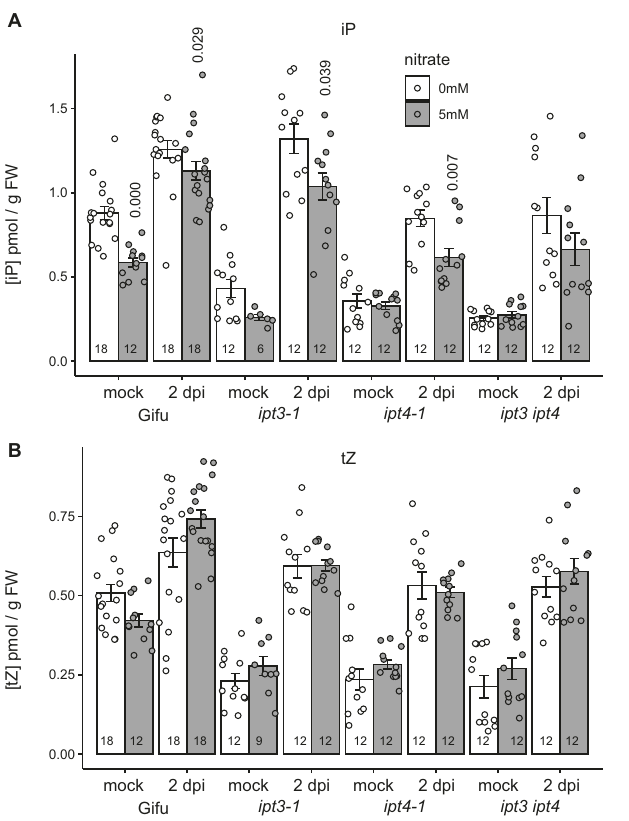
Fig. 2 ipt3 and ipt4 mutants show reduced root iP content in high nitrate conditions. A , B Cytokinin iP ( A ) and t Z ( B ) free base content analysed in mock or 2 days post inoculation with M. loti in the absence and presence of 5 mM KNO 3 using the same root tissue as illustrated in Fig. 1A. Bars show mean ± SE for the n value shown on each bar. Signi fi cant differences between nitrate presence and absence conditions as determined by Wilcoxon rank-sum test are indicated by the annotated P values. developed 7 dpi with M. loti . In the absence of nitrate, ipt3-2 ipt4-